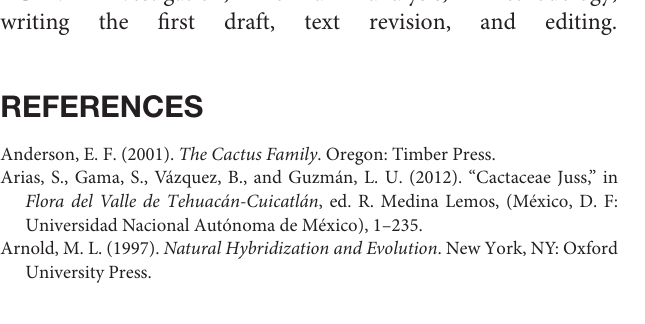
Supplementary Figure 1 | Neighbor net for 26 Opuntia individuals from 9